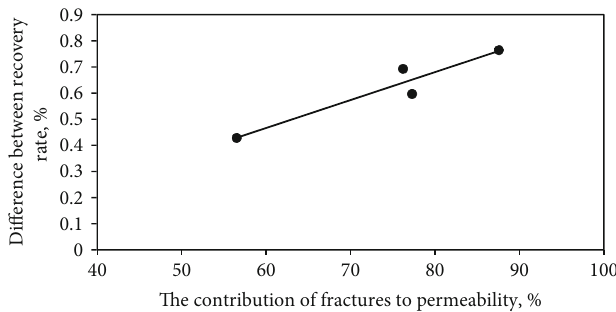
Figure 12: Di ff erential recovery of prefractured and fractured cores where water cut rises from 98% to